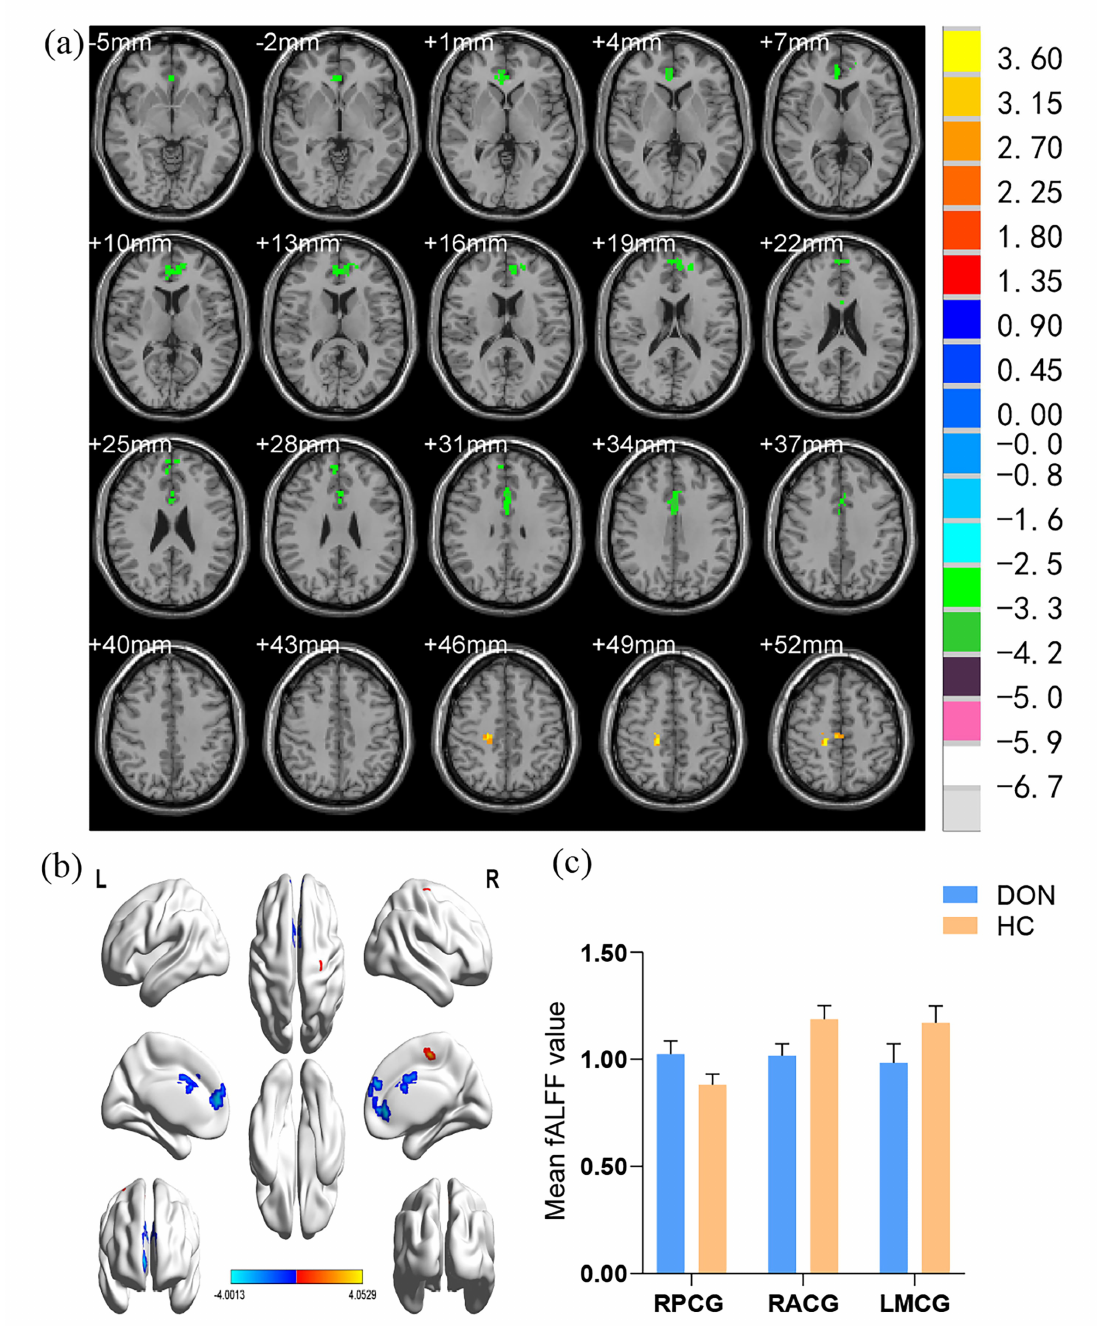
Fig. 2. Spontaneous brain activity in the DON group and HCs measured using the fALFF method. (a) A significant difference between DON and control group was observed in the RPCG, RACG, and LMCG regions (z.2.3, p = 0.01, cluster = 40 voxels, Alphasim corrected). (b) The stereoscopic form of the cerebrum. (c) The mean fALFF values between the two groups. DON, diabetic optic neuropathy; HCs, healthy controls; fALFF, fractional amplitude